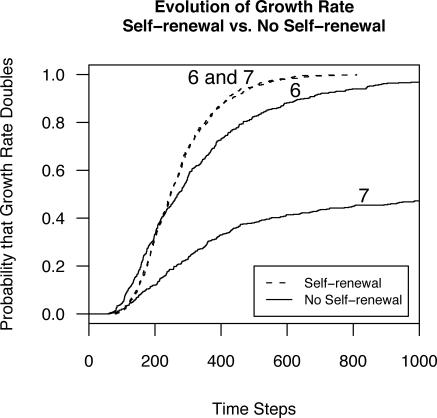
The Probability That the Average Growth Rate of the Population Doubles as a Function of Time, Number of Differentiation Stages (Six or Seven), and Self-Renewal by TACs Versus Serial Symmetric DifferentiationThe tissues with self-renewing TAC stages evolve more quickly than the tissues with strict serial differentiation, where, with the exception of the stem cells, both daughter cells of a mitosis differentiate into the next differentiation stage. TACs, dashed lines; serial symmetric differentiation, solid lines.